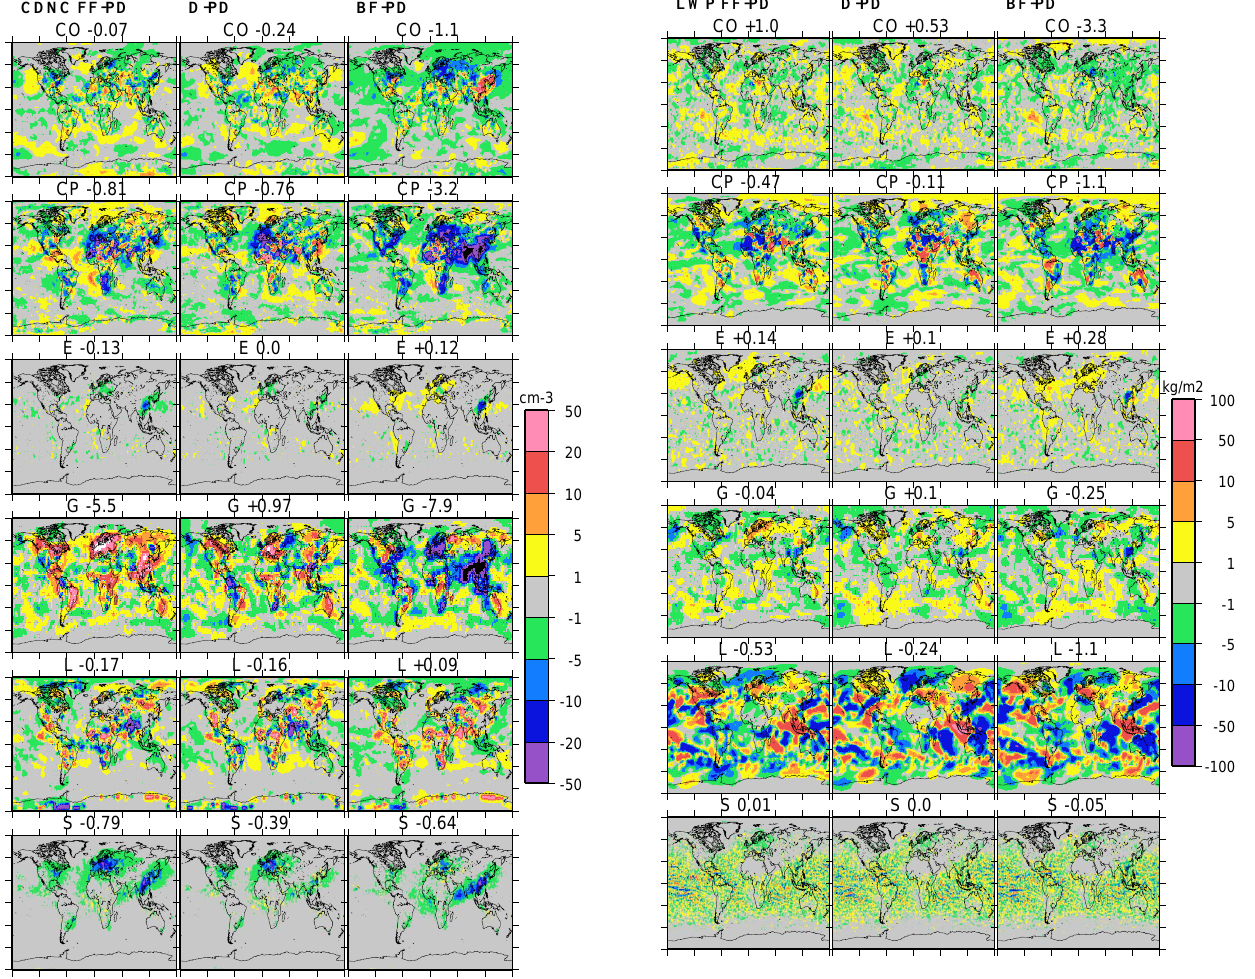
Fig. 2. Difference in annual mean cloud droplet number concen- tration (CDNC) between the fossil fuel (left), diesel (middle) and biofuel (right) reduction experiments and the full simulation. Each row is one model.